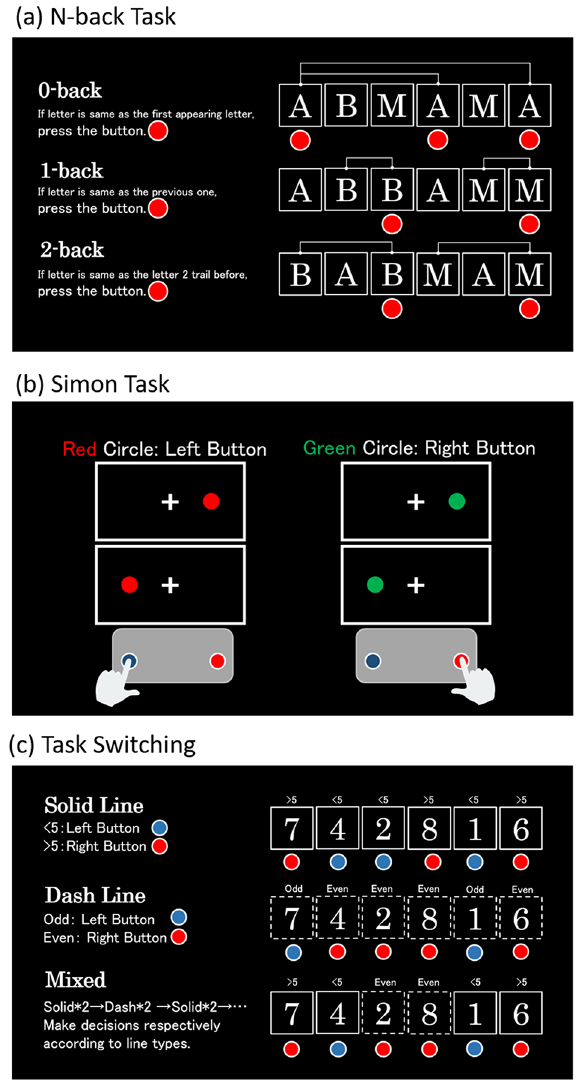
Figure 1. Illustration of three cognitive tasks. Participants were given detailed instructions before each task. All instructions were shown in Japanese during actual experiments.